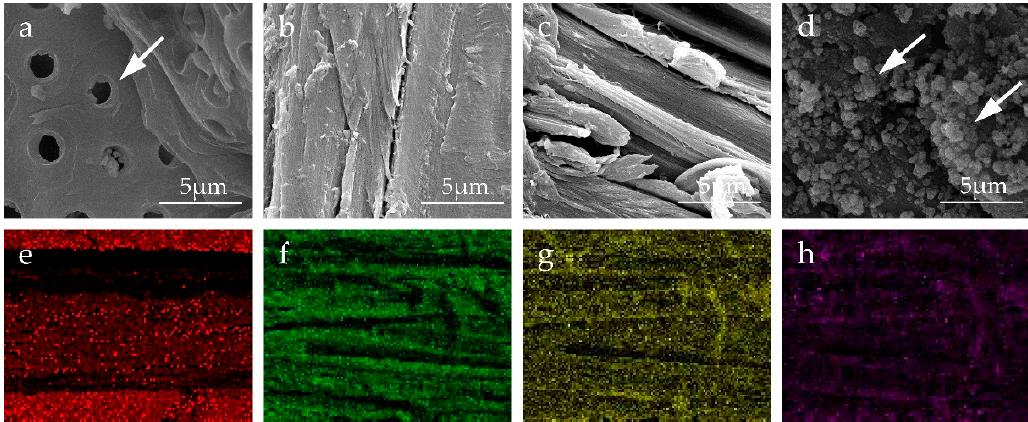
Figure 2. SEM images of ( a ) original wood; ( b ) CH coated wood; ( c ) CH / SP coated wood and ( d ) CH / SP / nano-TiO 2 -ZnO coated wood. Plane scan analysis of CH / SP / nano-TiO 2 -ZnO coatings interface: ( e ) element C; ( f ) element O; ( g ) element Zn; and ( h ) element Ti.